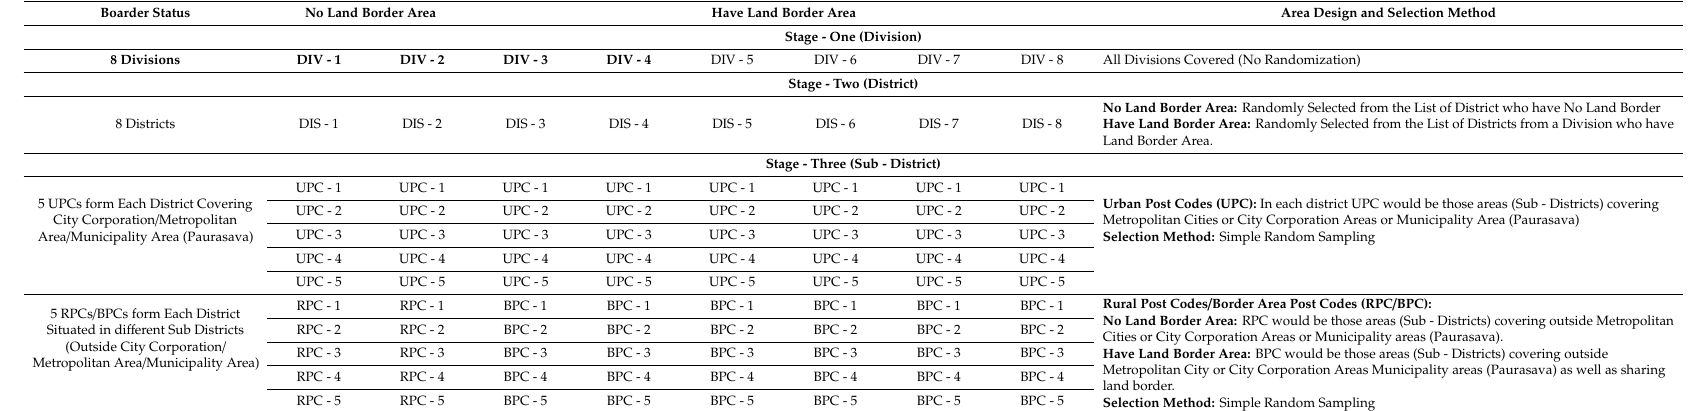
Table 2. Sampling Design.